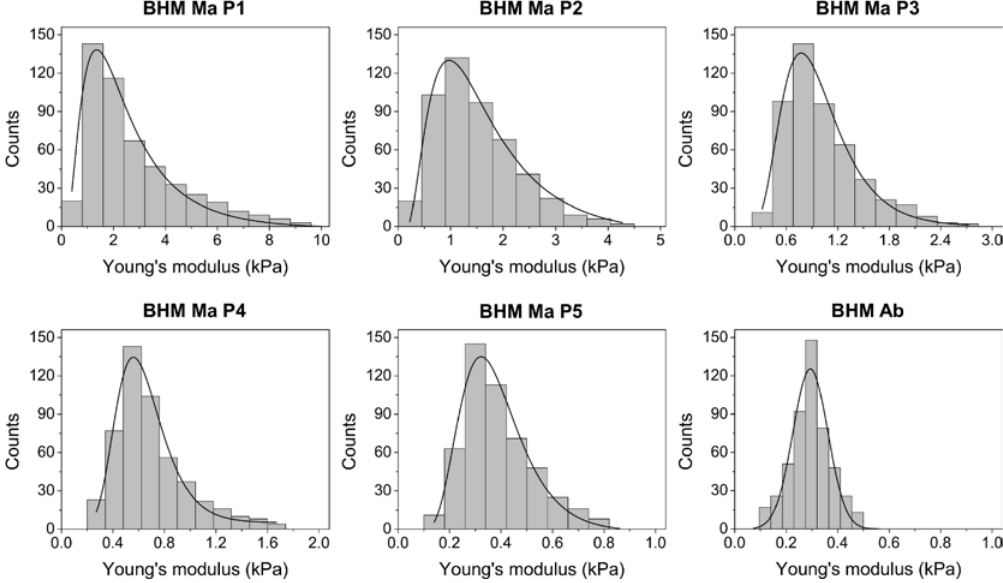
Figure 4. Histograms of the Young’s modulus values for the examined cells. Solid lines represent function fit to the data. In the case of BHM Ma cells, log-normal function was fitted, whereas for BHM Ab cells the Gaussian function was fitted. Note that the Young’s modulus data for BHM Ma cells becomes narrower and shifts towards lower values after each consecutive passage.